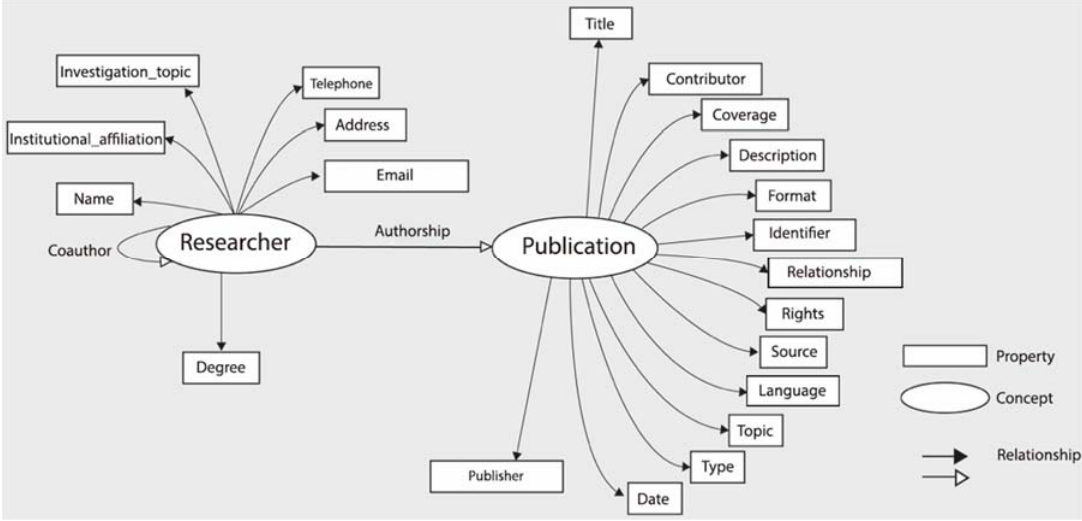
Figure 2. Authorship and co ‐ authorship relations in merging ontologies.